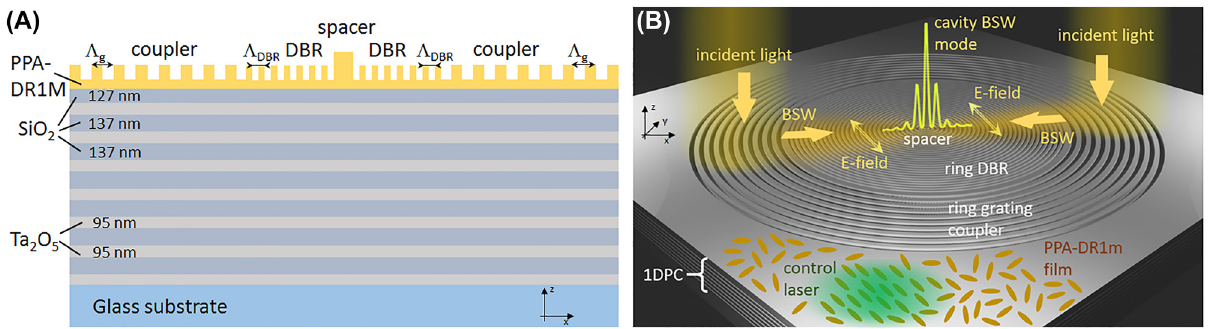
Figure 1: Resonant structure and principle of operation. (A) Vertical cross sectional view of the structure consisting of a dielectric multilayer on glass and a light-responsive polymer structure on top. (B) Illustrative 3D sketch of the resonant 1DPC patterned with the annular grating coupler and the BSW cavity constituted by a distributed Bragg reflector (DBR) surrounding an inner circular spacer. The pattern is inscribed into a 65 nm-thick azopolymeric blend film whose optical anisotropy can be controlled by orienting the alignment of the azobenzene molecules contained therein, via irradiation with an external green laser. The TE-polarized BSW coupling occurs along directions determined by the polarization of the incident white light. If the incident white light is unpolarized, BSW coupling occurs along all radial directions, as allowed by the circular grating. The control laser is typically expanded so that the whole pattern (cavity and grating coupler) is